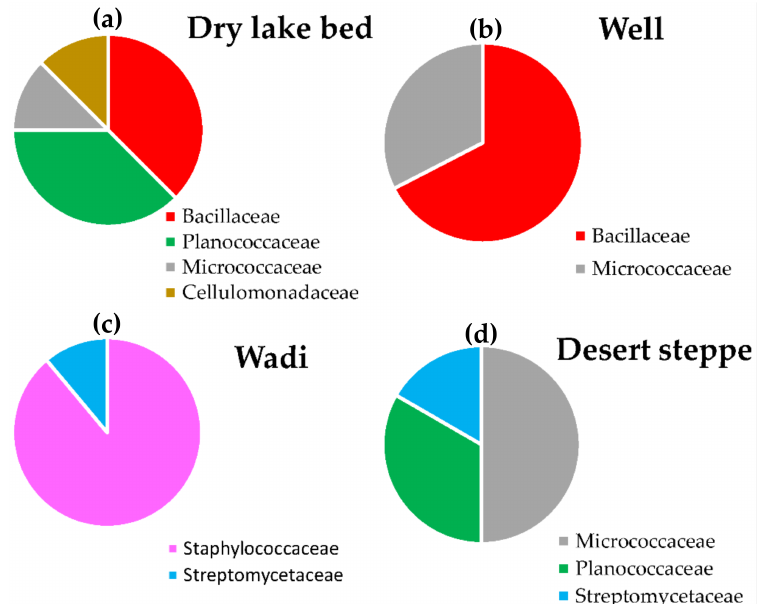
Figure 5. The bacterial species isolated from the dust saltation particles are shown in a pie chart. Each color chart shows the detection rate of each bacterial family at each research area, ( a ) dry lake bed, ( b ) well, ( c ) wadi, and ( d ) desert